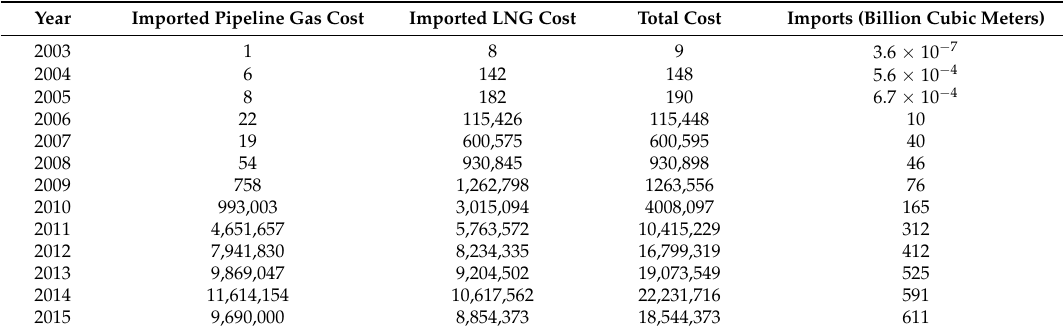
Table 3. Costs of natural gas imports (units: current 1000 USD).